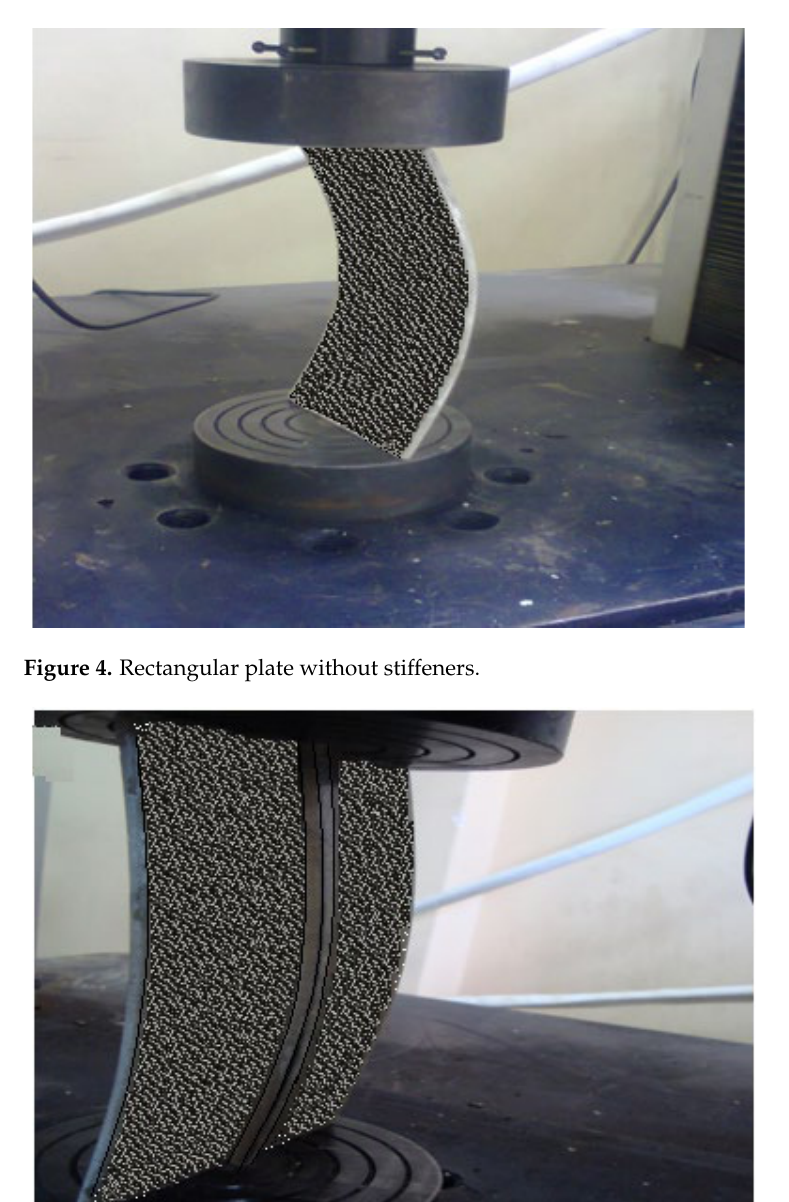
Figure 3. Buckling test machine.